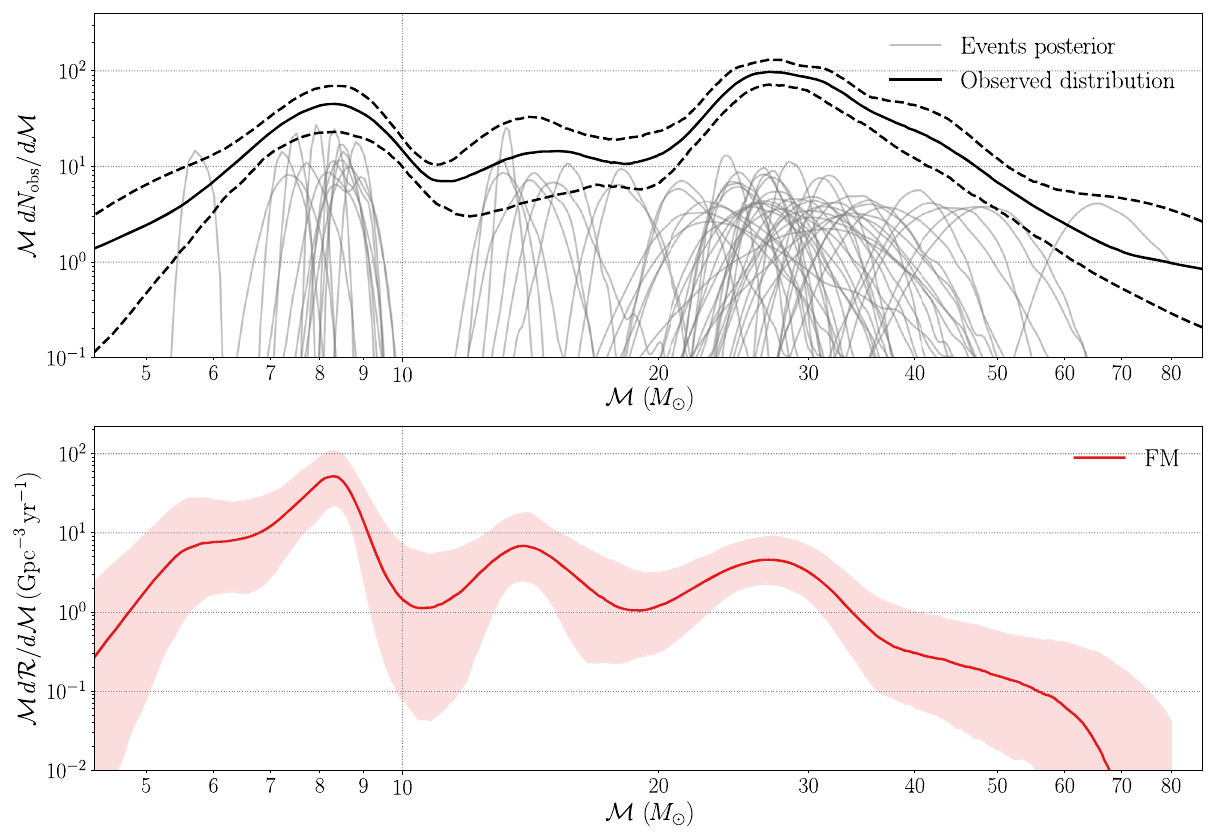
FIG. 2. Illustrating substructure in the source chirp-mass distribution for a BBH (with FAR < 1 yr − 1 , excluding GW190814, as in Sec. VI). All event inferences shown adopt the same fiducial PE priors shown in Fig. 1 and described in the text. Top: the individual- event observations versus chirp mass (gray) and an inferred distribution of the observed chirp-mass distribution (black solid) using an adaptive kernel density estimator [115,116]. The kernel bandwidth is optimized for the local event density and a 90% confidence interval (black dashed) is obtained by bootstrapping [117]. Bottom: the solid curve is the predicted underlying source chirp-mass distribution obtained using the flexible mixture model framework (FM); see Sec. III for details. Unlike the top panel, this panel accounts for our selection effects. The distribution shows three clusters at low masses and a relative deficit of mergers in the chirp-mass range 10 − 12 M ⊙